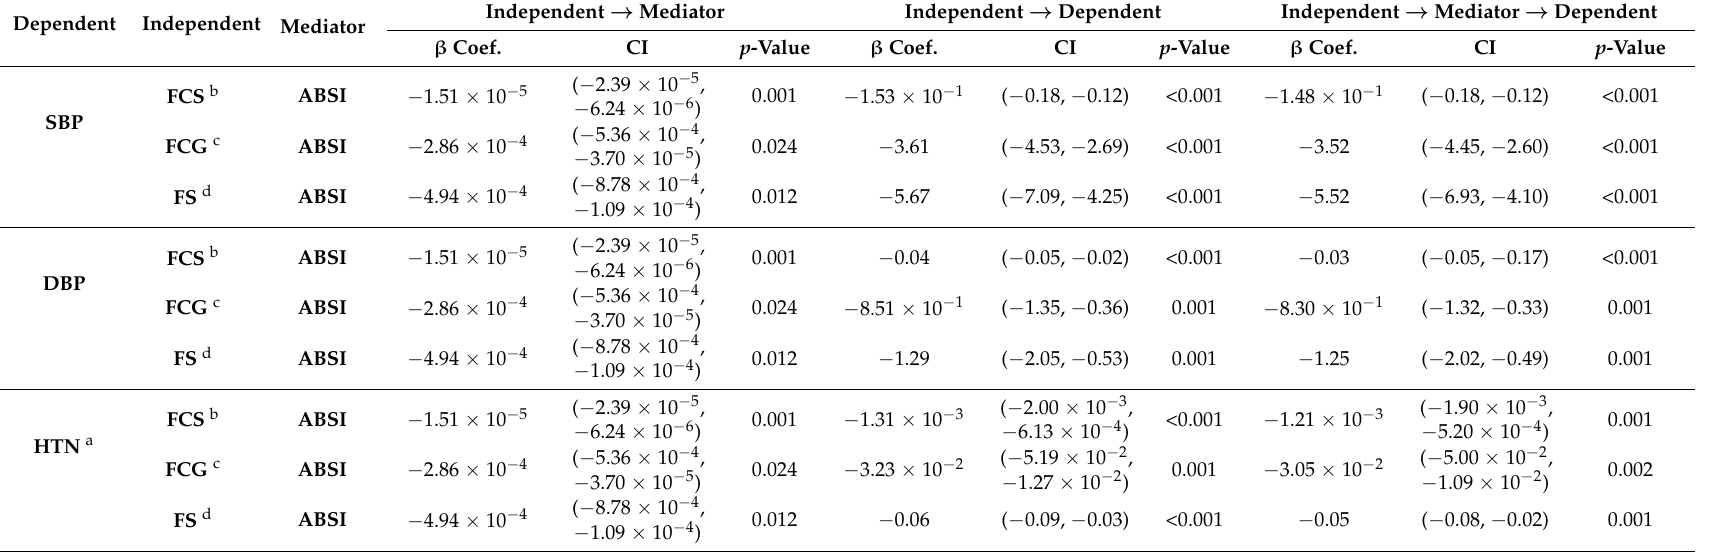
Table 4. Mediation analysis between food security as an independent variable, ABSI as a mediator variable, and hypertension as a dependent variable. Independent → Dependent Independent Mediator